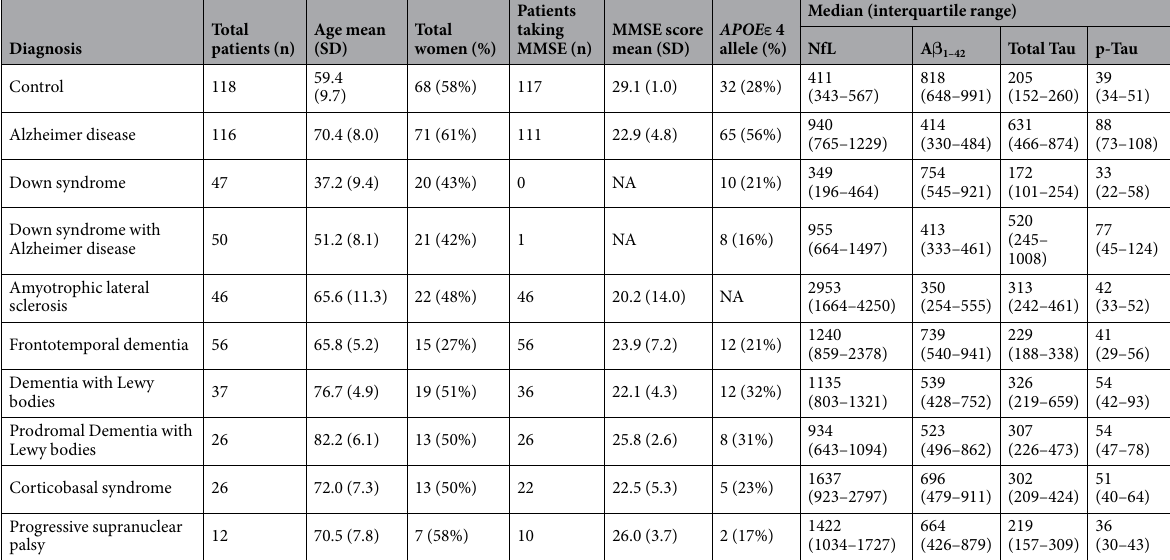
Table 1. Demographic and clinical data, cognitive scores, APOE e4 status and CSF biomarker concentrations of all participants. Abbreviations: MMSE: Mini-Mental State Examination, NA: Not Applicable,